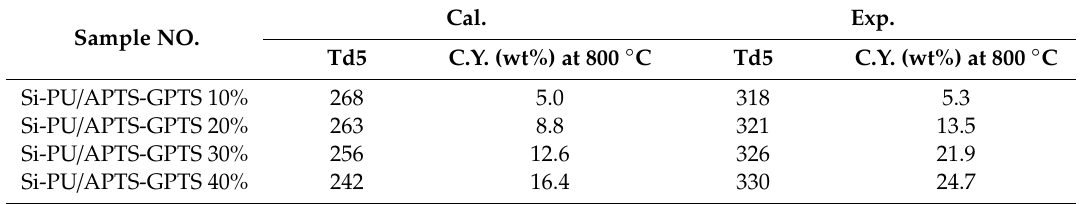
Table 3. Comparison of calculated and experimental TGA data of Si-PU / APTS-GPTS composites. Sample